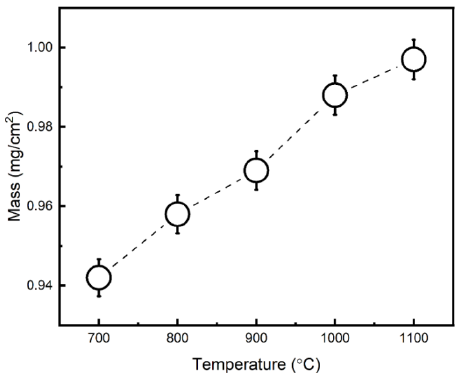
Figure 8. Mass gain with respect to different exposure temperatures, i.e., 700 °C–1100 °C.